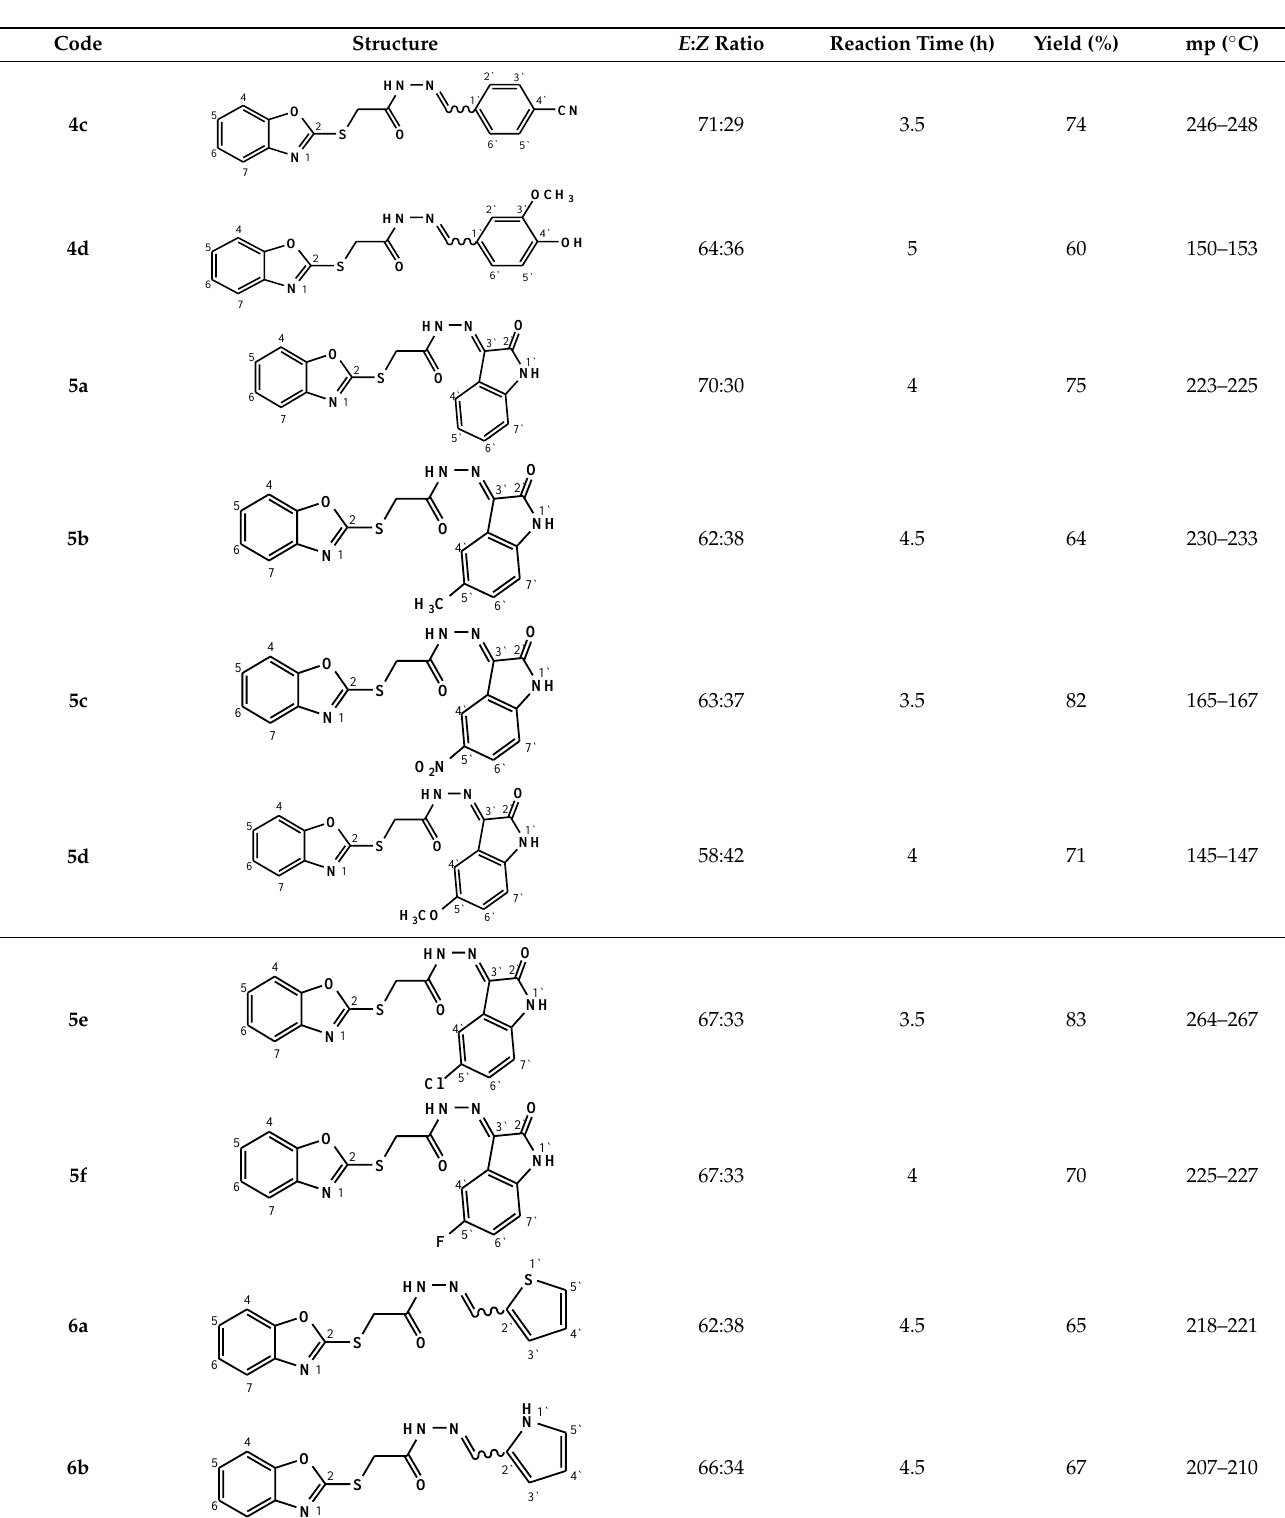
5 of 21 Table 1. Structures, E:Z ratios, reaction times, yields, and melting points of the synthesized compounds, 4a – 6b.